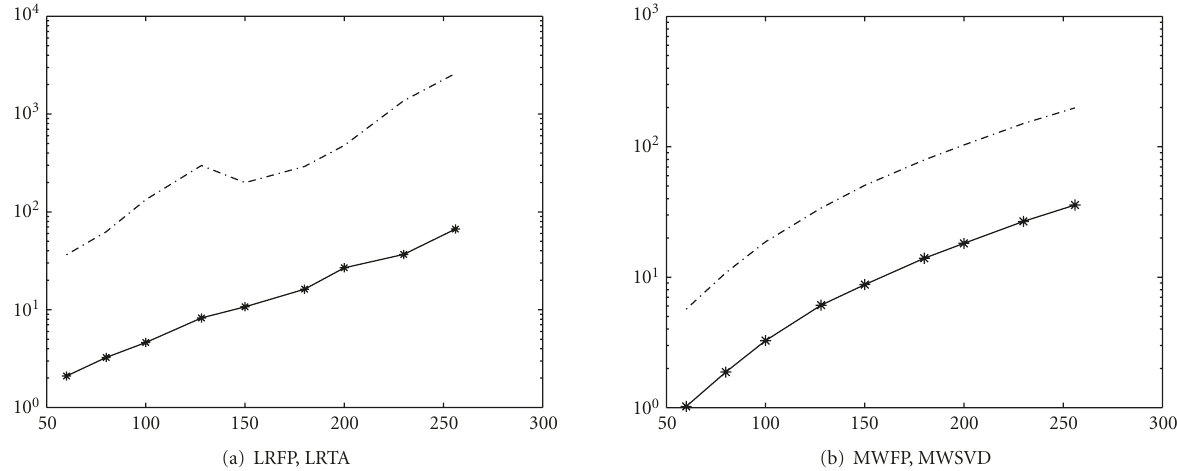
Figure 3: Computational times (s) as a function of the number of rows and columns: tensor filtering using (a) LRFP (- ∗ -), LRTA (- · -); (b) MWFP (- ∗ -), MWSVD (- ·